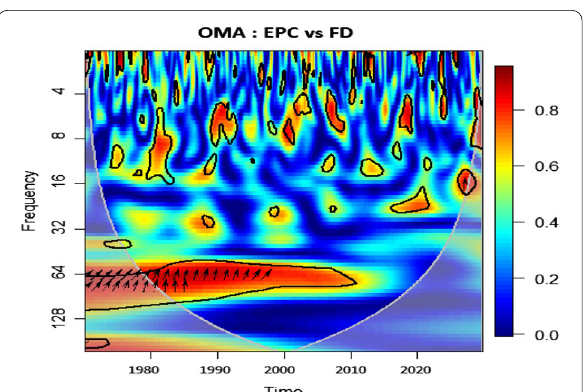
Fig. 5 Comovement between the electrical power consumption and financial development in